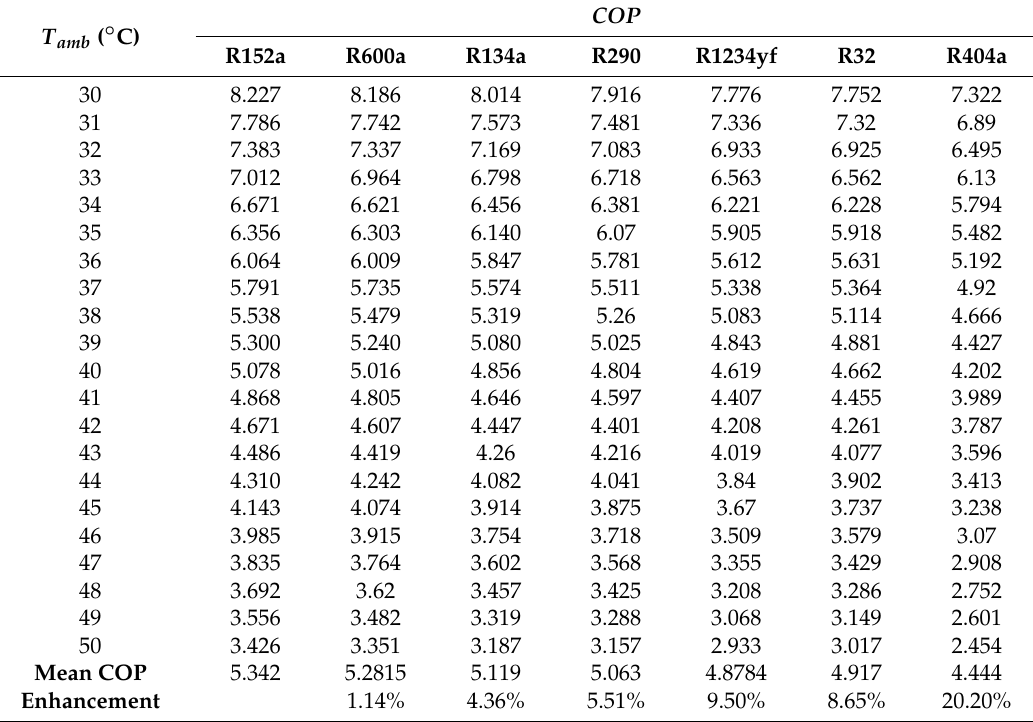
Table 4. Comparison of the different working fluids with R152a for Q e = 5 kW and T ind = 25 ◦ C. T amb ( ◦